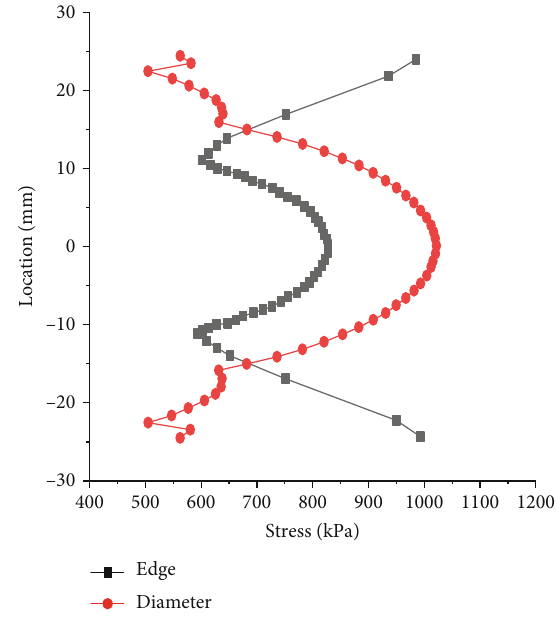
Figure 8: Central circular section equivalent stress distribution (22 ° , 26 ° , and 30 ° ).